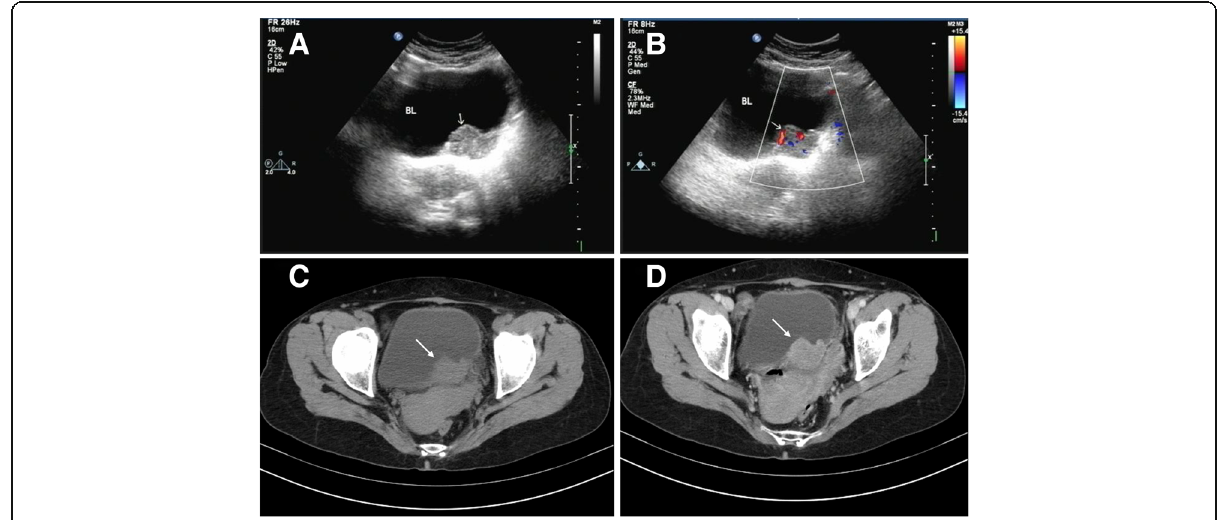
Fig. 1 Abdominal ultrasound examination indicates a 43×28 mm slightly enhanced echo on the left side of the bladder wall ( a ). Color Doppler Flow Imaging detects a strip-like blood flow signal and records the pulsatile flow spectrum ( b ). Pelvic-enhanced computed tomography examination shows nodular soft tissue shadow at the left posterior wall of the bladder ( c ), which was obviously enriched after enhancement ( d